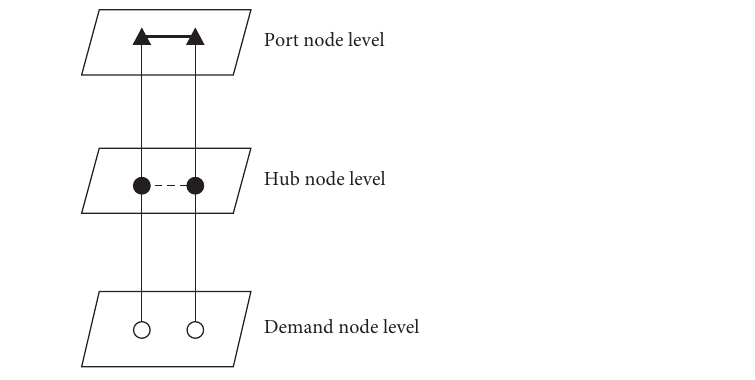
Figure 3: Node level of CR Express transportation network. It shows the three different node levels for modelling and describing a transport network. Table 1: The variables used for the p-hub median model in condition of fixed discount coefficient.